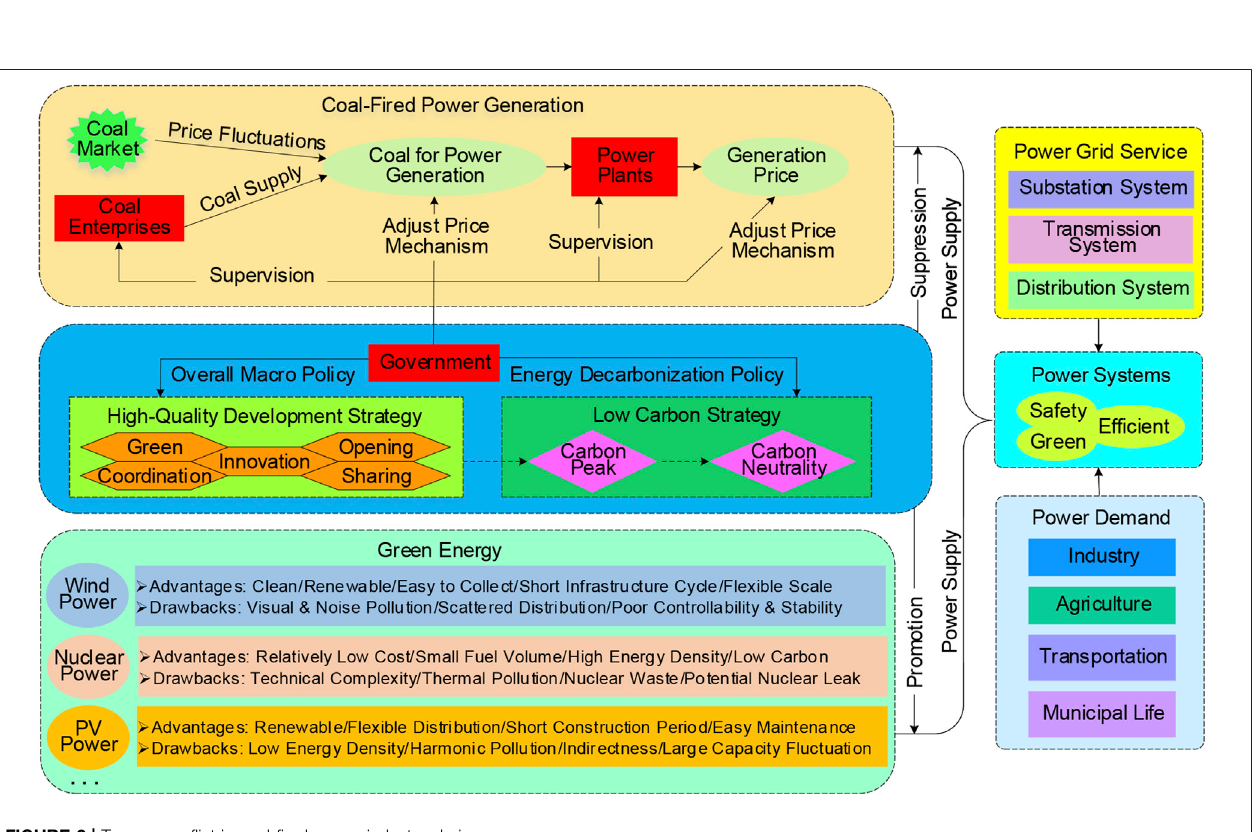
FIGURE 2 | Ternary con fl ict in coal- fi red power industry